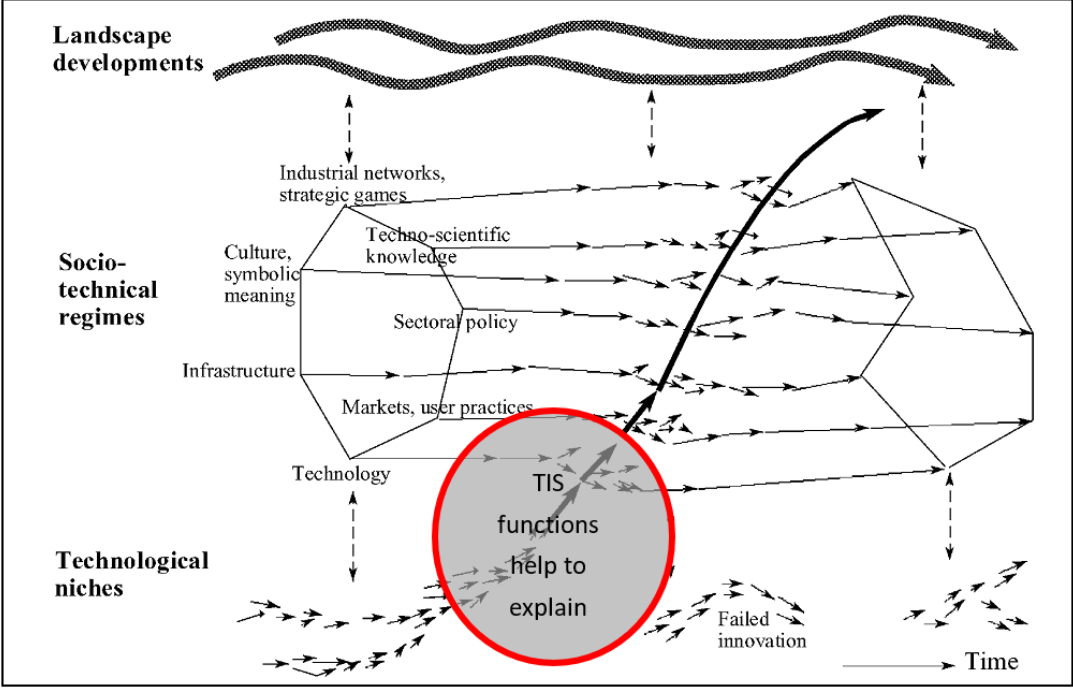
Figure 2. From Geels (2002), authors’ modifications. TIS functions comprising the original seven functions of Hekkert et al. in addition to the Demonstrating Value function could be helpful in explaining the mechanisms by which technological niches break out into the regime.